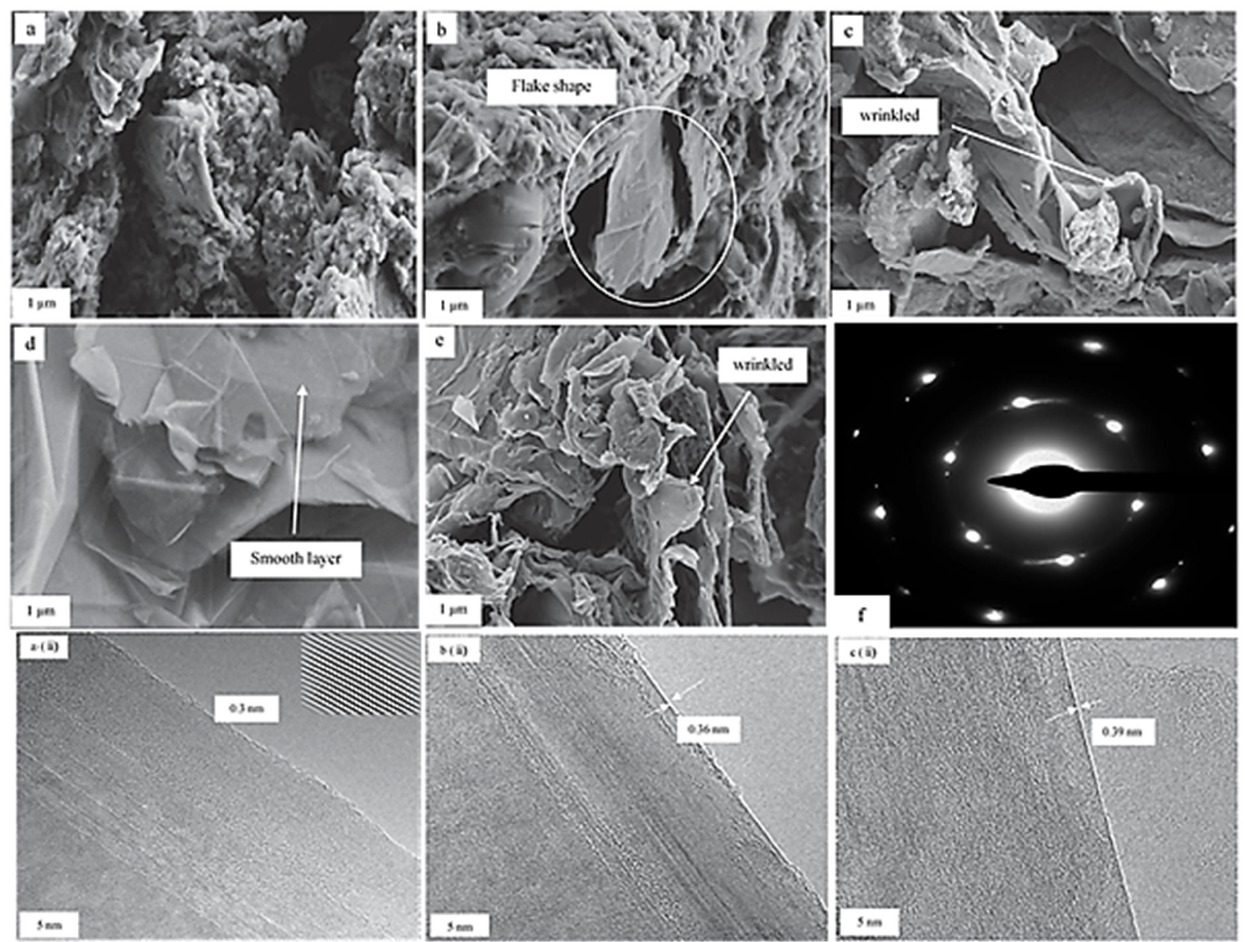
Figure 8. FESEM images: ( a ) Pure graphite; ( b ) graphene obtained after exfoliating in H 2 SO 4 electrolytes without sonication time and with varied durations of sonication of ( c ) 15 min, ( d ) 45 min, and ( e ) 60 min. HRTEM micrographs of graphene produced using ( aii ) H 2 SO 4 , ( bii ) (NH4) 2 SO 4 , and ( cii ) H 3 PO 4 electrolytes for sonication of 45 min at magnifications of 5 nm. ( f ) SAED pattern of graphene attained using H 2 SO 4 . Adopted with permission from